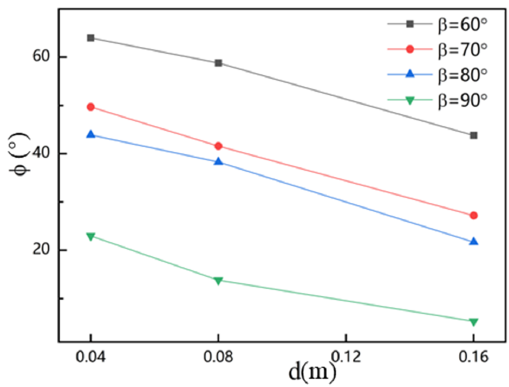
Figure 22. Effect of crack spacing on crack propagation angle.